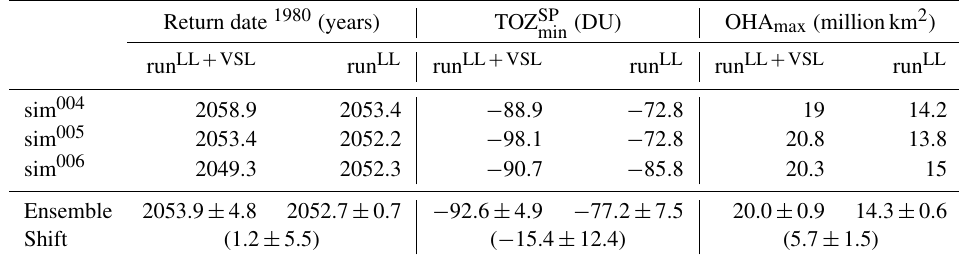
Table 1. Estimation of the ozone return date, minimum ozone column within the southern polar cap (TOZ SP area (OHA max ) modelled with CAM-Chem for different simulations and ensemble